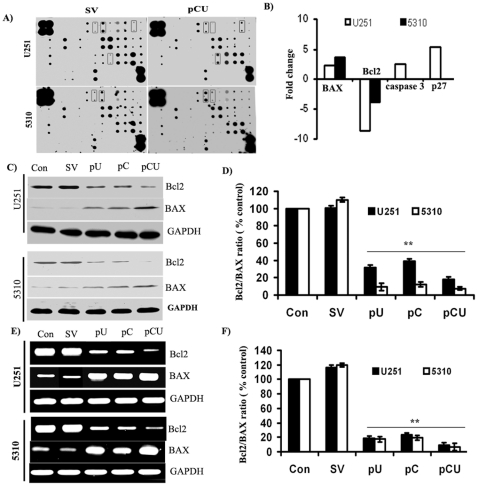
Effect of uPAR and cathepsin B downregulation on the expression of pro- and anti-apoptotic molecules.(A) Expression of pro- and anti-apoptotic molecules in U251 and 5310 cells 72 hrs after transfection with SV or pCU. Human apoptosis antibody arrays were exposed to cell lysates and processed as per the manufacturer's instructions. (B) Densitometric analysis and graphical representation of fold change of pro- and anti-apoptotic molecules. (C) Western blot analysis of Bcl-2 and Bax expression in U251 and 5310 cells 72 hrs transfection. The blots were stripped and re-probed with GAPDH antibody to verify equal loading. The experiments were repeated three times and representative blots are shown. (D) Densitometric analysis showing the Bcl-2/Bax ratio in U251 and 5310 cells. Columns: mean of triplicate experiments; bars: SE; **p<0.001. (E) Semi-quantitative RT-PCR analysis of Bcl-2 and Bax mRNA expression in pU-, pC- and pCU-transfected U251 and 5310 cells. Total RNA was extracted 72 hrs after transfection, and cDNA was synthesized as described in Materials and Methods. PCR was set up using first-strand cDNA as the template for Bcl-2, Bax and GAPDH. (F) Densitometric analysis showing the Bcl-2/Bax mRNA ratio. Columns: mean of triplicate experiments; bars: SE; **p<0.001, significant difference from untreated control or SV-transfected control.